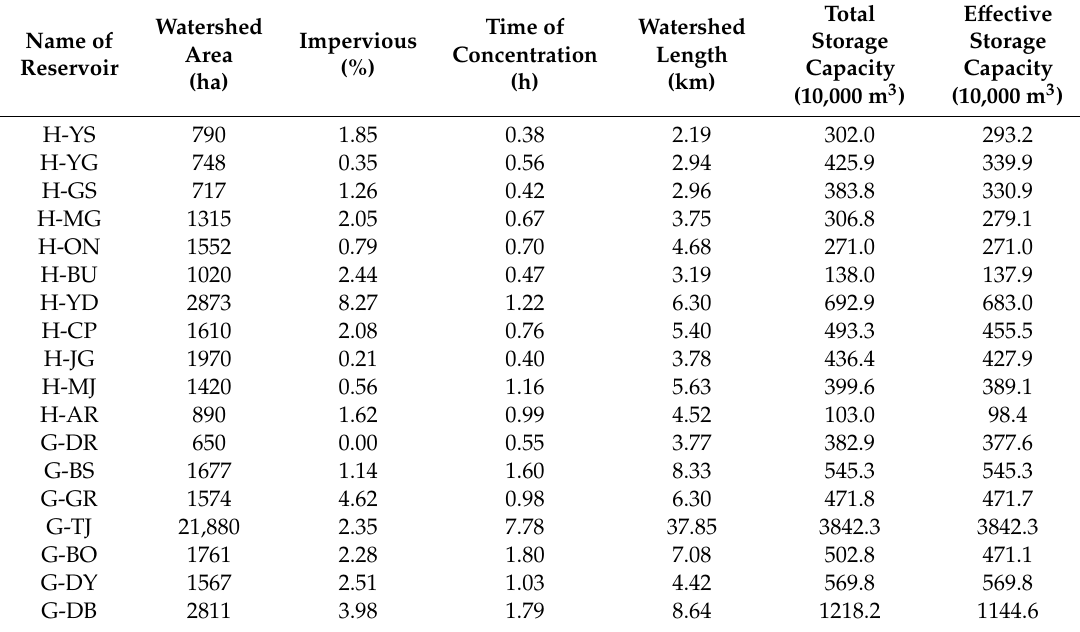
Table 1. Watershed characteristics and design specifications for the 30 agricultural reservoirs. These data were constructed from the basic plan reports and emergency action plan reports in South Korea